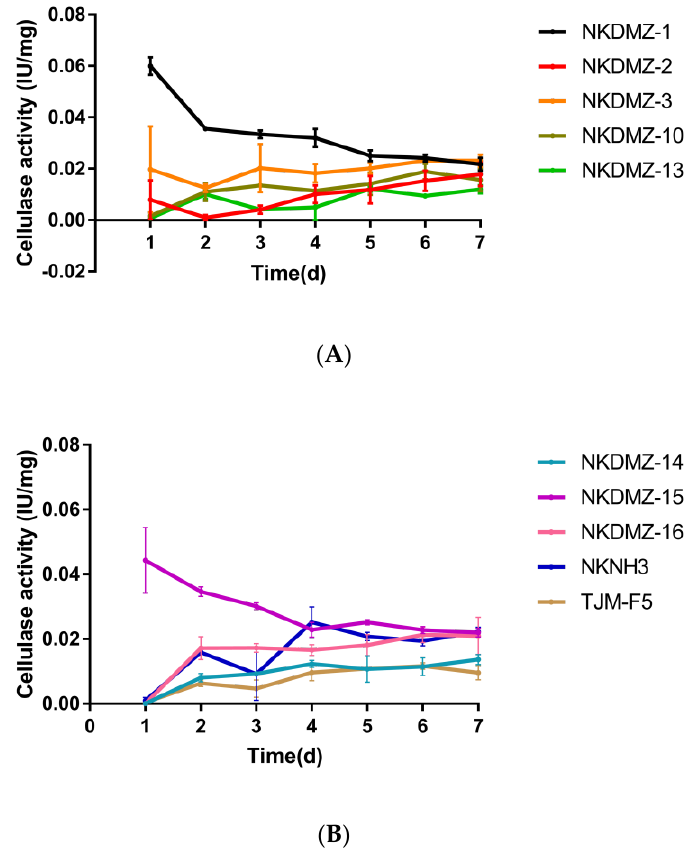
Figure 4. Detection of the cellulase activity of 10 fungal isolates by DNS method. The 10 fungi which showed the cellulose degradation capability were assessed for cellulose activity every 24 h. Each fungus is represented by a different color .